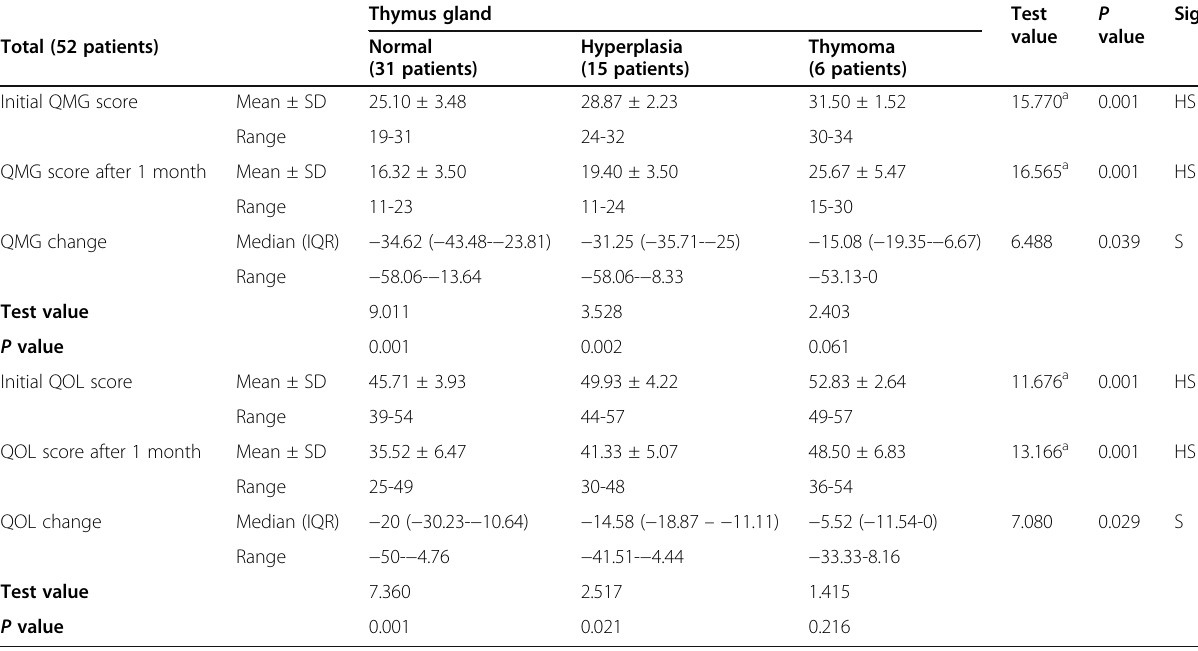
Table 5 Relation between thymus gland pathology of the studied patients and studied scores Thymus gland Test